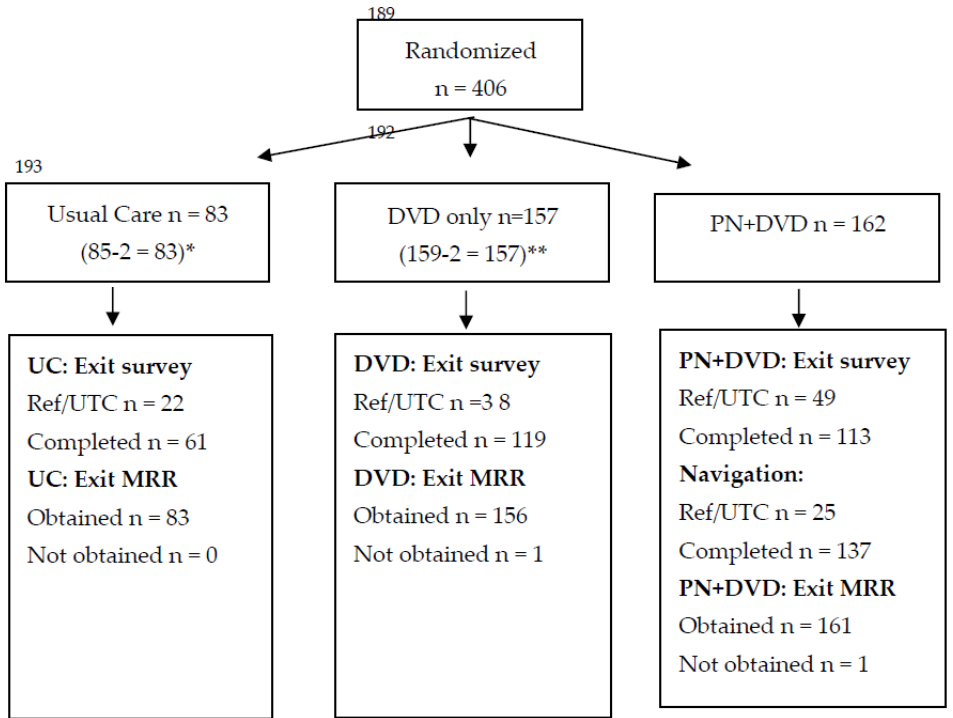
Figure 1. CONSORT Diagram. * Post randomization, 2 participants from Usual Care were ineligible: One person had no 12-month medical record or self-report outcome data, and one person was ineligible because it was determined that they were UTD with all screenings at baseline. ** Post randomization, 2 participants from the DVD group were determined to be ineligible because they were UTD with all screenings at baseline. Table 1. Baseline characteristics by randomized study